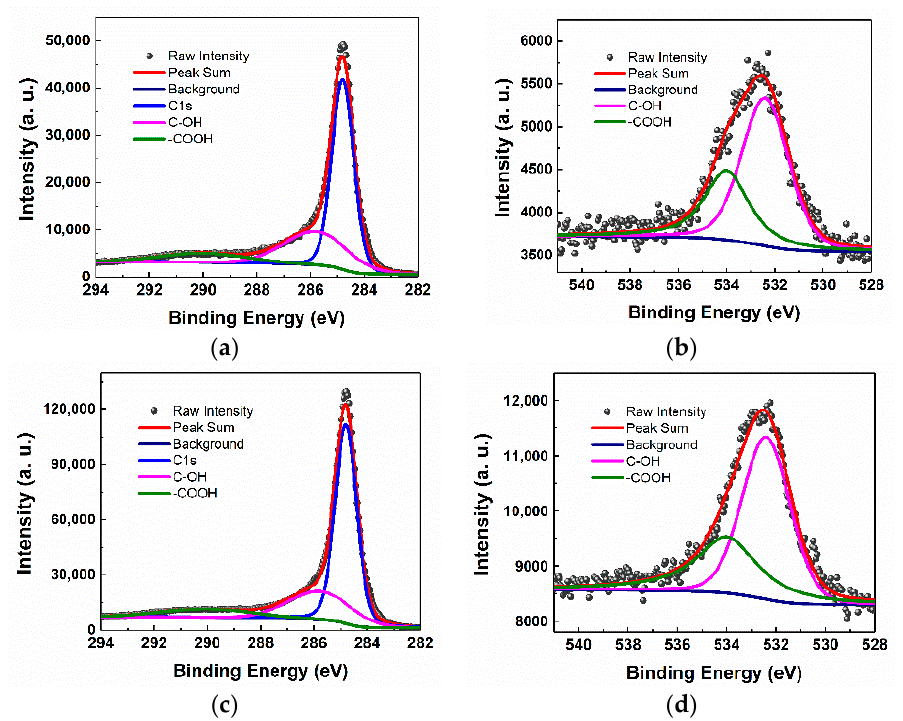
Figure 2. X-ray photoelectron spectroscopy (XPS) spectra of the C 1s and O 1s for ( a , b ) CRF and ( c , d ) GCCA-150.